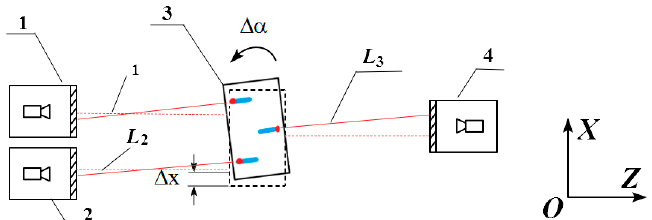
Figure 4. Sketch map. 1. reference monitoring image acquisition module A; 2. reference monitoring image acquisition module B; 3. laser transmitter module; 4. image acquisition module.